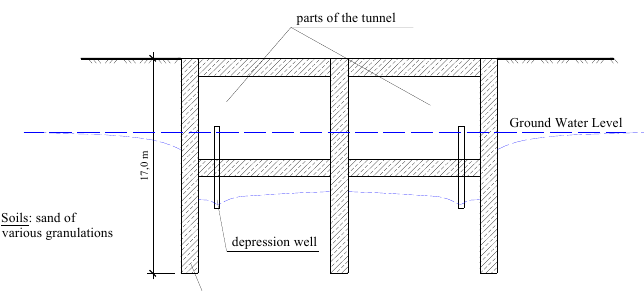
Figure 5. Cross section of the tunnel.